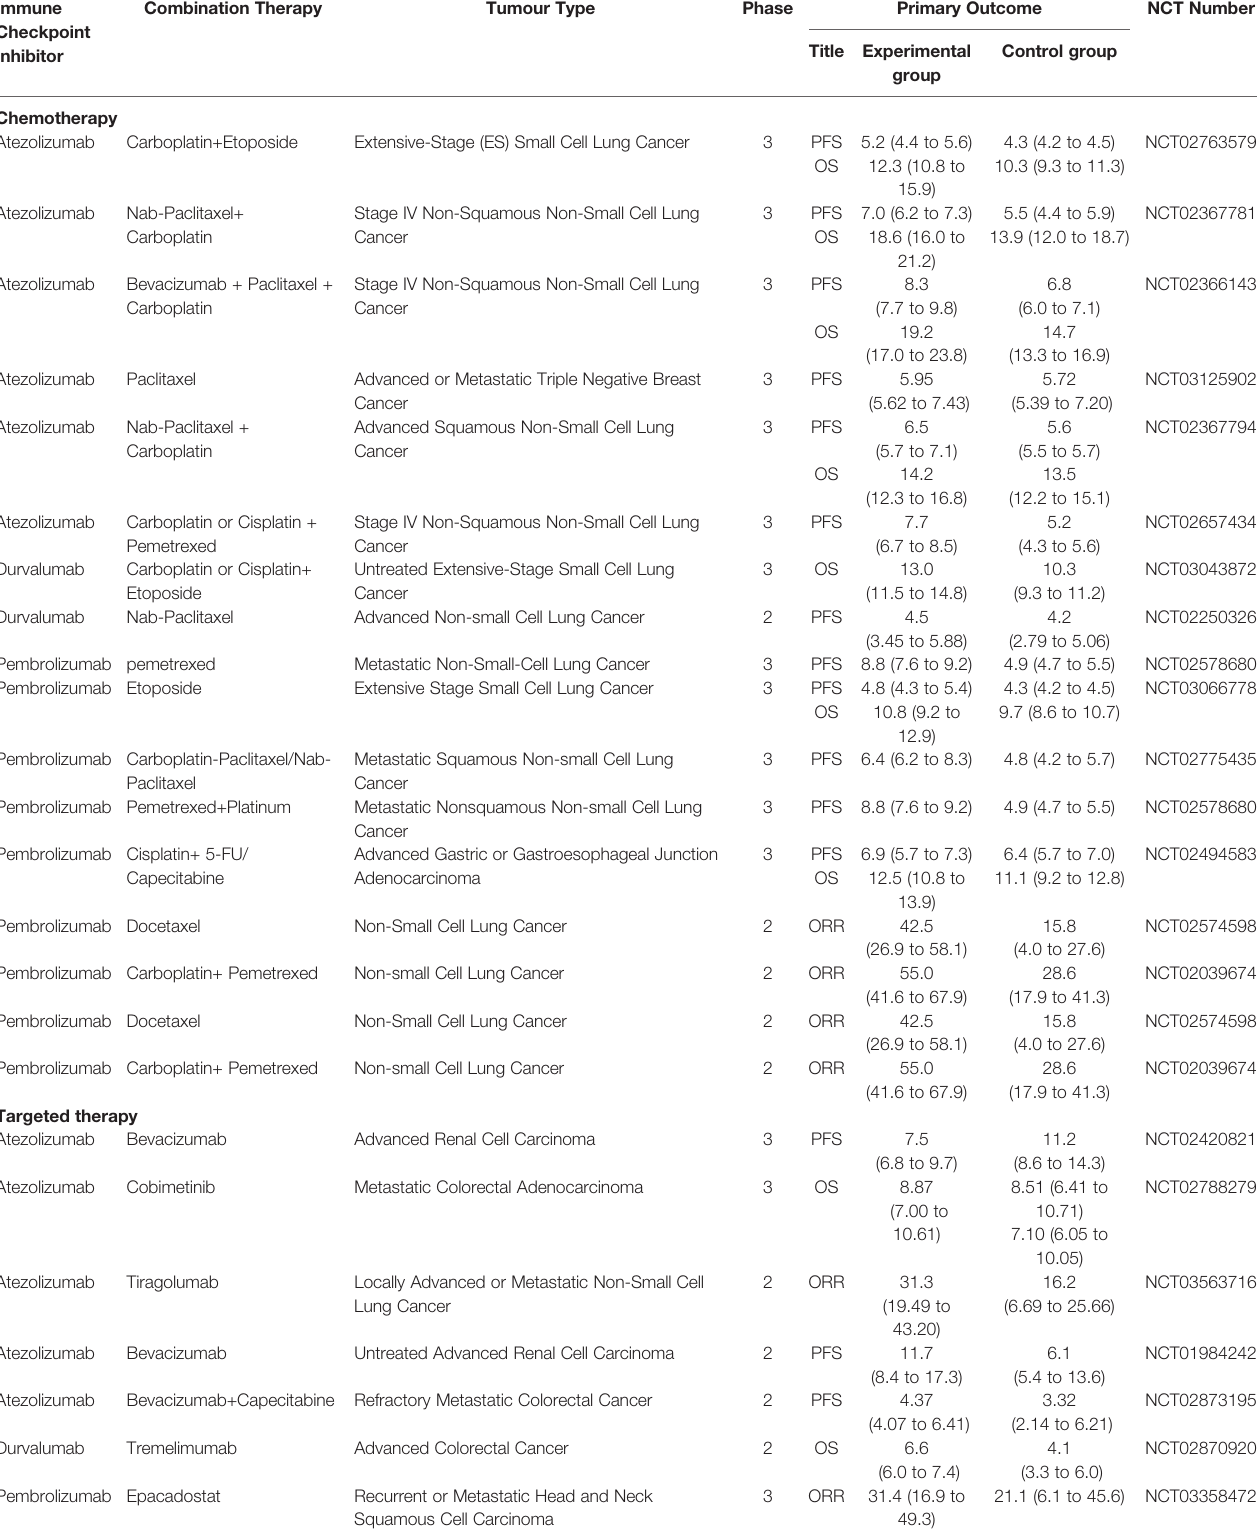
TABLE 3 | Various uses of PD1/PD-L1 inhibitor in oncology. Immune